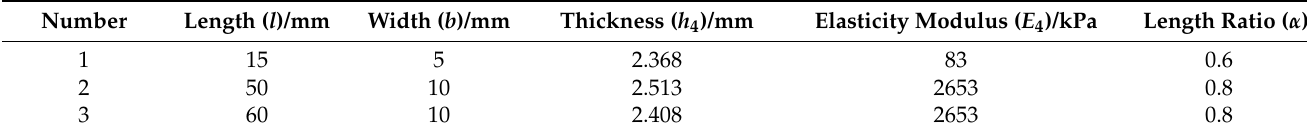
Table 1. Parameters of the uniform strength beam of the prepared tactile